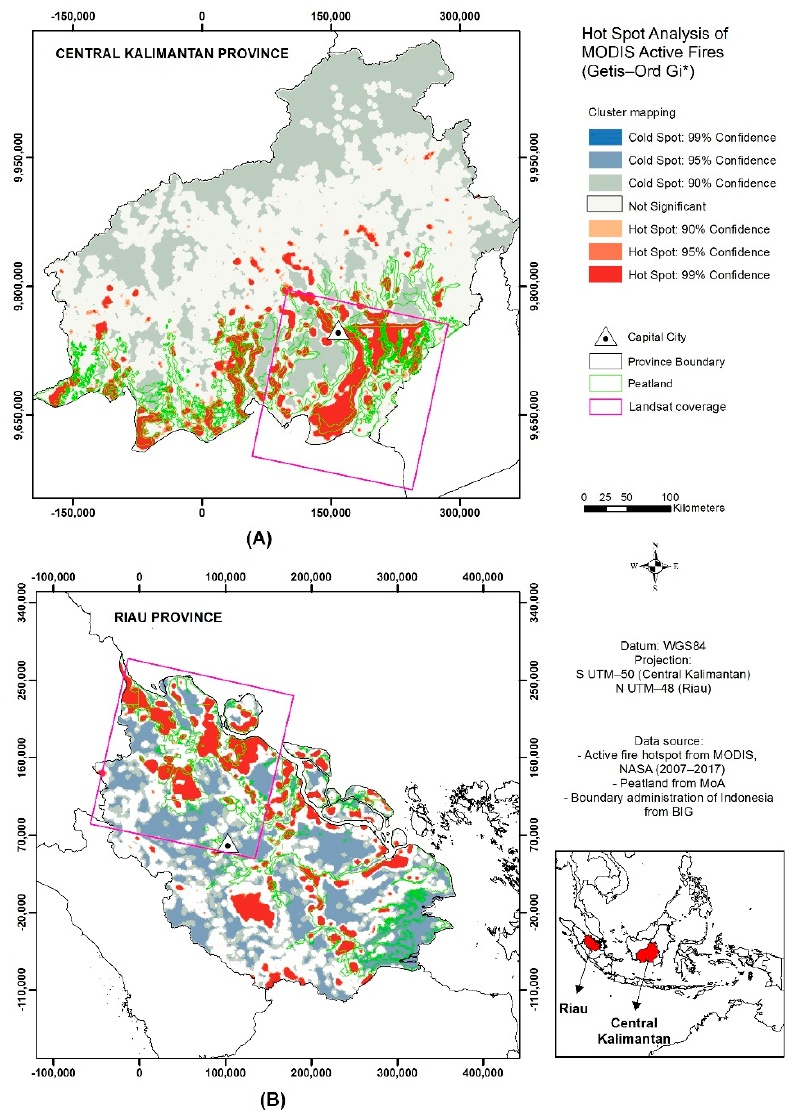
Figure 1. ( A ) The algorithm development site analysed from the Getis–Ord optimised hotspot applied to 1 km grid cell counts of Moderate Resolution Imaging Spectroradiometer (MODIS active fires (2007–2017) overlaid on peatland map in Central Kalimantan and ( B ) Validation site in Riau Province. The Hot Spots in red tones represent the high density of MODIS active fires with statistically significant confidence levels from 90% to 99%, while the Cold Spots, in blue tones, represent the low distribution of fire hotspots with statistical significance from 90% to 99%. The white colour is not statistically significant. The MODIS active fire source from The National Aeronautics and Space Administration-Fire Information for Resource Management System (NASA-FIRMS). Peatland map sources from the Ministry of Agriculture (MoA). The boundary administration is from Geospatial Information Agency